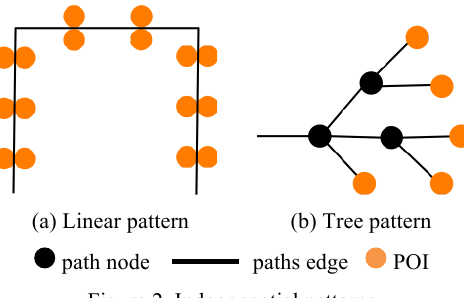
Figure 2. Indoor spatial